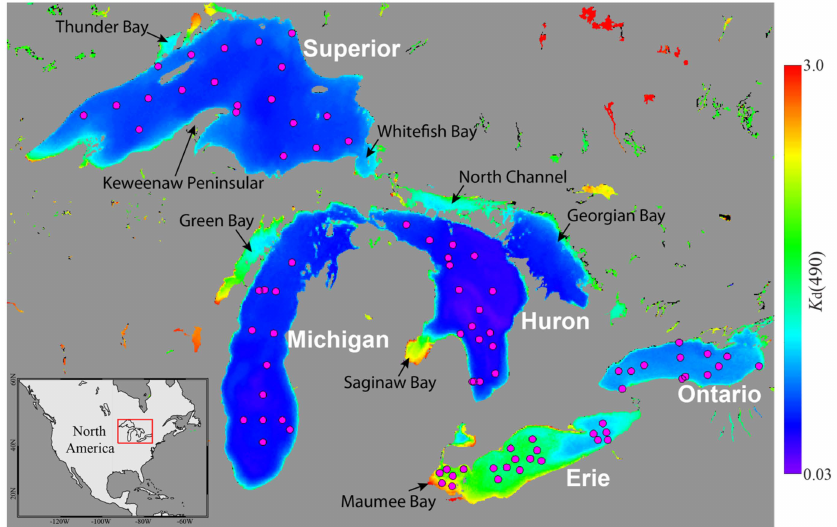
Figure 1. Map of the Great Lakes with the marks (pink circles) indicating in situ data locations for water turbidity measurements on the Visible Infrared Imaging Radiometer Suite (VIIRS)-derived climatology K d (490) image (2012–2018). Names of the five lakes are noted in the right side of lakes, and the map of North America is also shown in the left bottom as the location of the Great Lakes indicated in the red